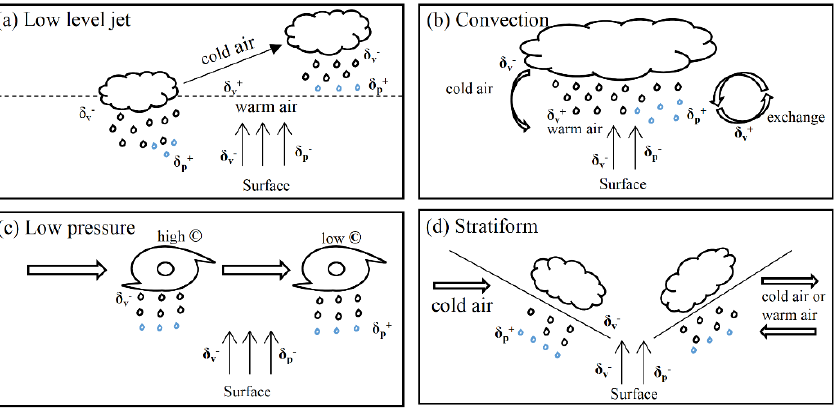
Figure 1. Isotopic variations of typical rain events: ( a ) low-level jets; ( b ) convection; ( c ) low-pressure systems, where © is water vapor concentrations; and ( d ) stratiform precipitation. The plus in the superscript indicates an increase in the isotope ratios of water, while the minus indicates a decrease in the isotope ratios of water. For example, the warm surface water vapor rises and mixes with water vapor at high altitude in low-level jets, the value of δ v at high altitude rises briefly. Large raindrops experiencing re-evaporation under the clouds during their falling become small and the escape of light isotopes within the raindrops results in relatively high δ p values within the raindrops. The isotopic composition of both precipitation and water vapor in all rain events were affected by kinetic effects (such as surface evapotranspiration, re-evaporation of raindrops and exchange with surrounding air), resulting in the heavy isotopes in precipitation not being as enriched as expected and the light isotopes of water vapor not being as depleted as predicted.